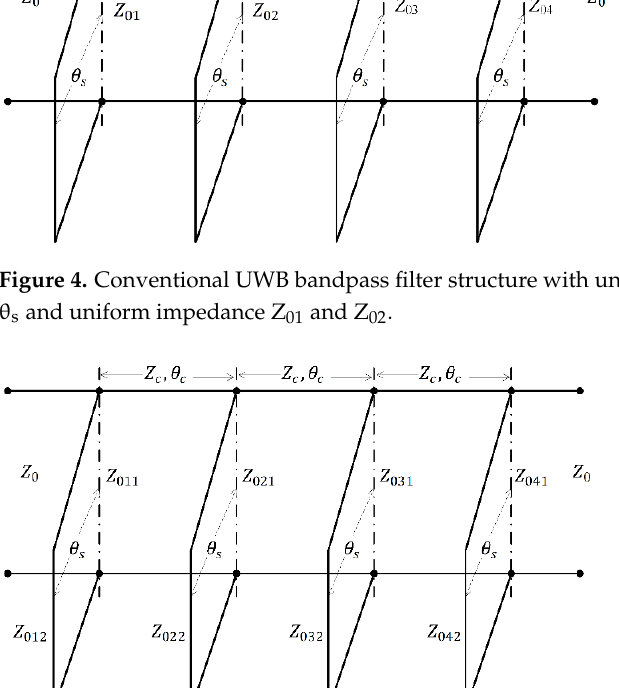
Figure 6. Layout of the proposed microstrip UWB bandpass filters with tapered resonators. Figure 7. UWB filter with LC equivalent resonators. Figure 8. Simulated S − parameters results of the lumped element filter represented in Figure 7. -90-75-60-45-30-150 1 2 3 4 5 6 7 8 9 10 11 12 S - P a r a m e t e r s ( d B ) Freq. (GHz) S11 S12